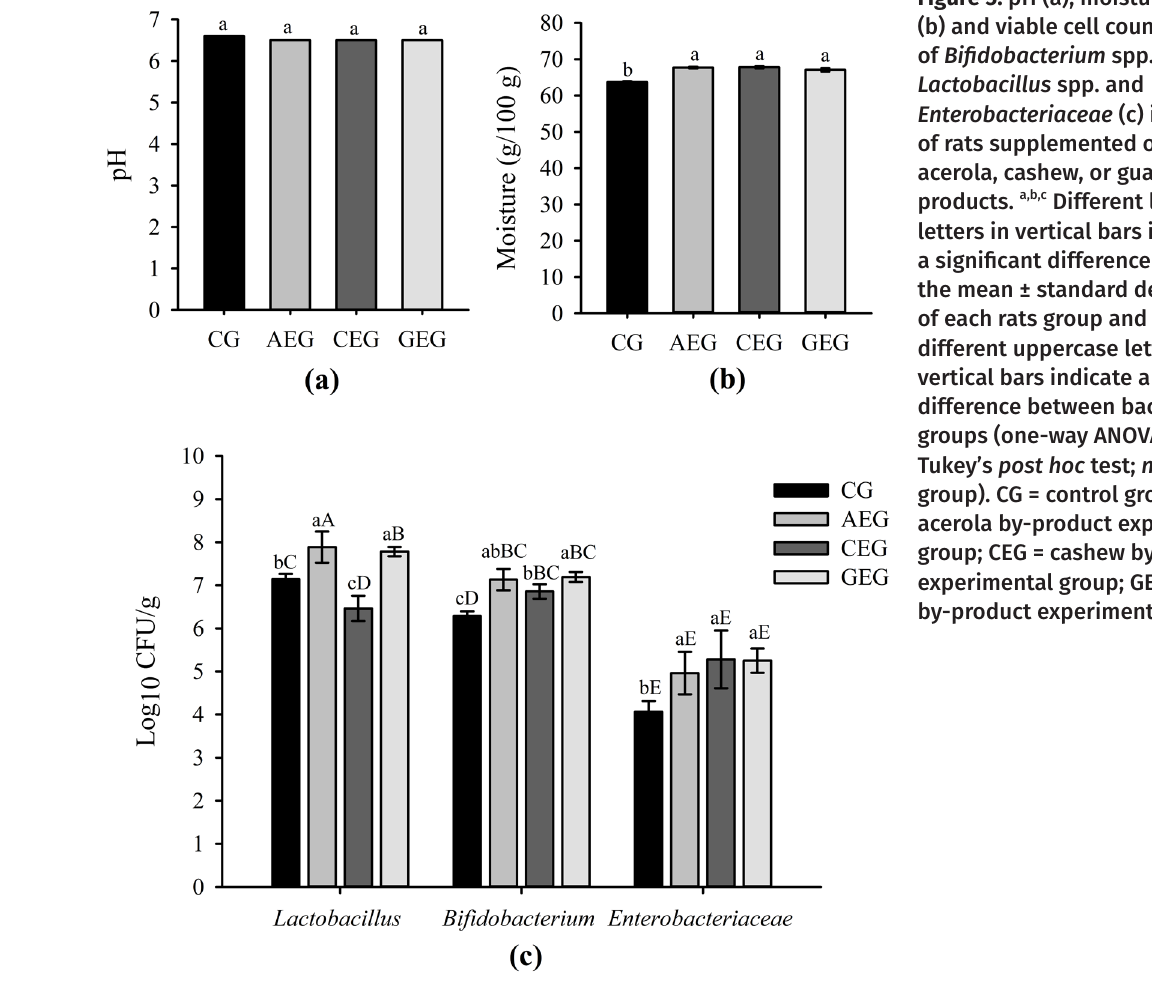
Figure 5. pH (a), moisture (b) and viable cell count of Bifidobacterium spp., Lactobacillus spp.